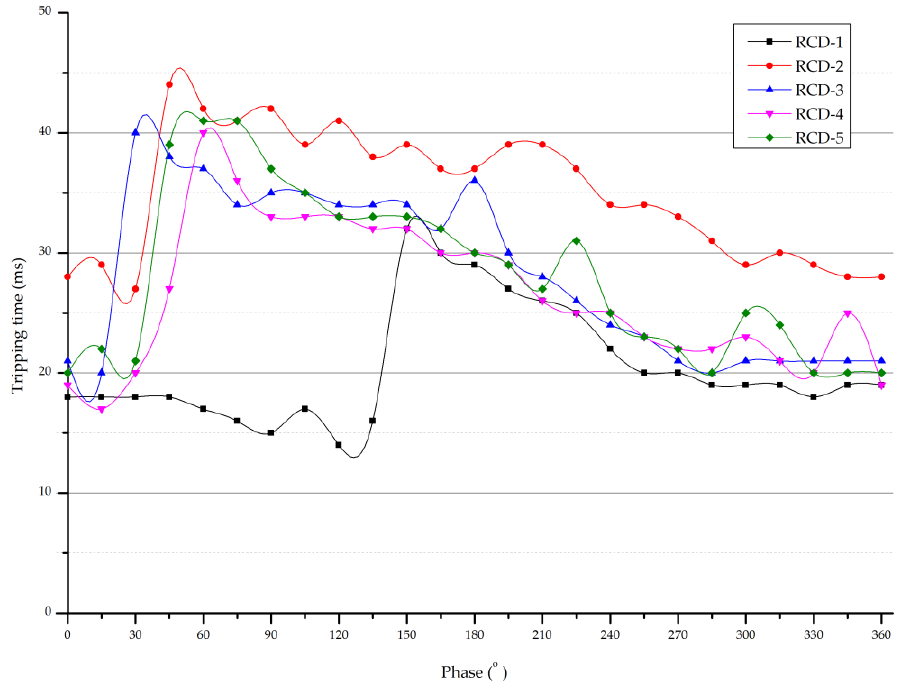
Figure 15. The dependencies of RCD-1–5 break time versus initial phase of the test current ( I ∆ = 30 mA, 50 Hz).